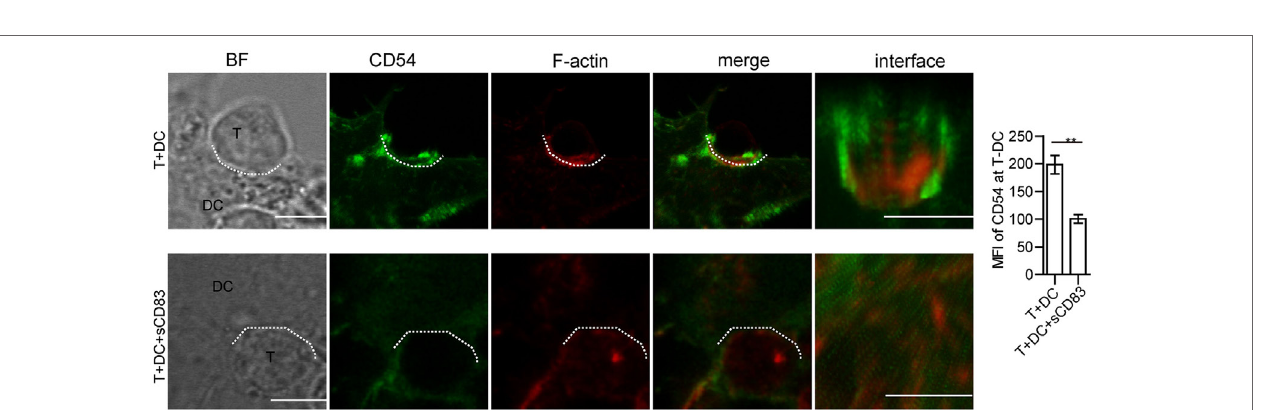
FigUre 7 | Soluble CD83 (sCD83) disrupts cytoskeletal filamentous actin (F-actin) and the topology of calcium microdomains in antigen-presenting dendritic cells (DCs). The localization of molecules on T cells and DCs was analyzed by confocal microscopy. T–DC doublets were chosen from bright field images and evaluated using fluorescence image stacks. (a) Localization of ORAI1 (green) and mitochondria (red) at the contact zone of sCD83-treated DC2.4-T cells and untreated DC2.4-T cells. The dotted lines mark the synapse of DC2.4-T. Scale bar = 5 µm. (B) The mean fluorescence intensity (MFI) of ORAI1 or mitochondria at the contact zone of T cell–DC interaction. Mean ± SEM, 15 cell-contacts were measured for every group from three independent experiments, two-tailed Student’s t -test. ** p < 0.01. (c) The expression of F-actin in DCs in contact with T cells (red) and sCD83-pretreated DCs co-cultured with T cells (blue) was analyzed by flow cytometry (isotype: gray). Mean ± SEM, n = 15 cells from three independent experiments, two-tailed Student’s t -test. *** p < 0.001. (D) The distribution of F-actin (red) in DCs, sCD83-pretreated DCs, cytochalasin D-pretreated DCs, and sCD83-pretreated DC2.4 with F-actin overexpression. Scale bar = 5 µm. (e) Co- localization analysis of F-actin (blue), ORAI1 (green), and mitochondria (red) at the DC2.4-T cell synapsis, and the effect of sCD83, cytochalasin D, and F-actin overexpression. The dotted lines mark the DC–T synapse. Scale bar = 5 µm. The right panels show the enlarged view of the contact zone. A three-dimensional image of DC–T contact was reconstructed. Scale bar = 2 µm. (F) Quantification of the MFI of ORAI1, mitochondria, and F-actin at the contact zone in different conditions. (g) The mean calcium concentration in contacting T cells and DCs was assessed. Data of (F,g) are shown as mean ± SEM, n = 15 for every group from three independent experiments. One-way ANOVA LSD- t test. N: no significant, *** p < 0.001, ** p < 0.01, * p <